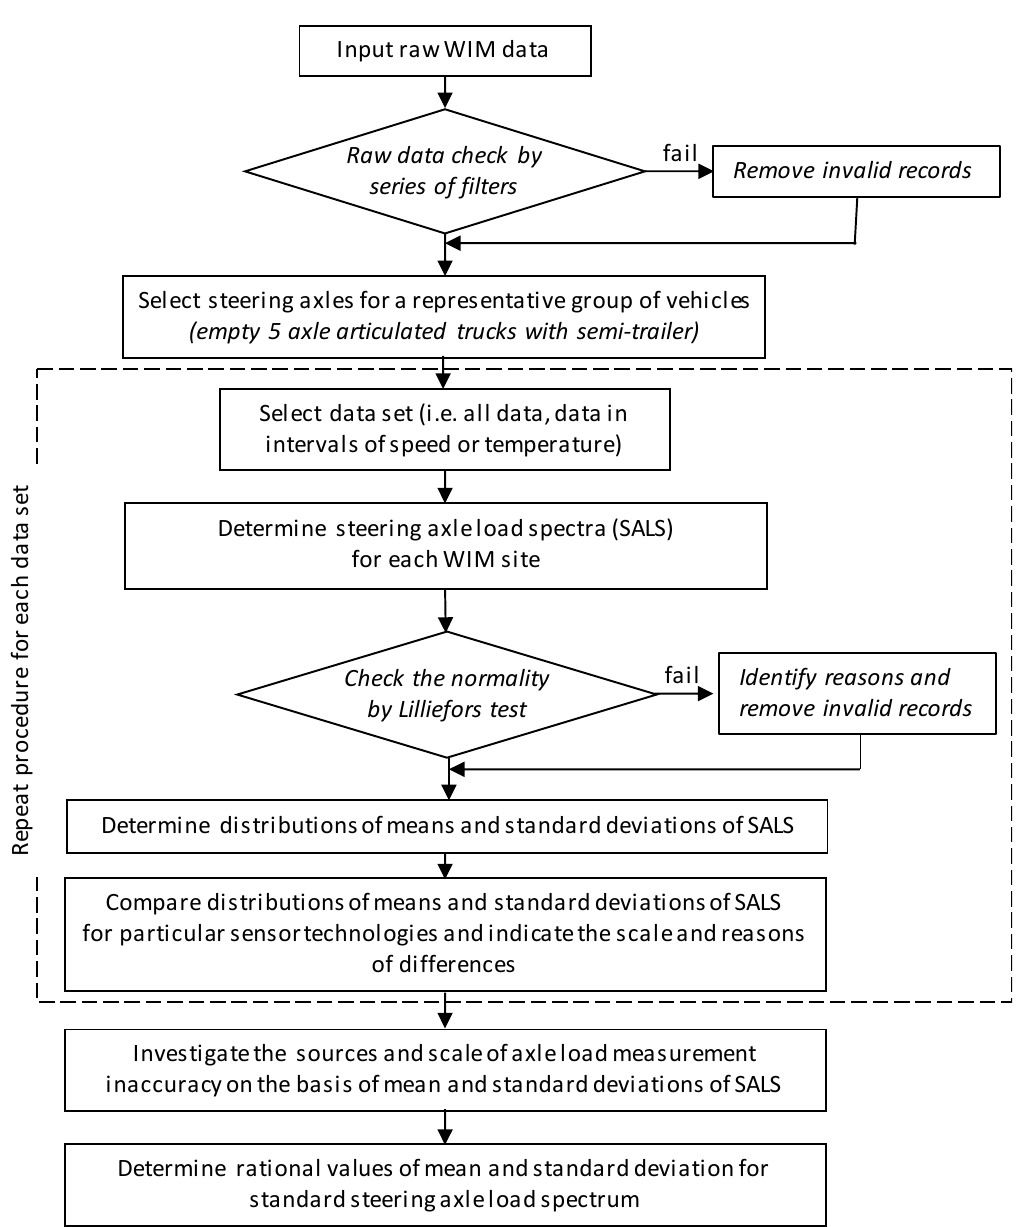
Figure 2. Scheme of the steps performed in the analysis to investigate the scale and sources of errors on weigh - in -m otion (WIM) stations and to determine the standard steering axle load spectrum.